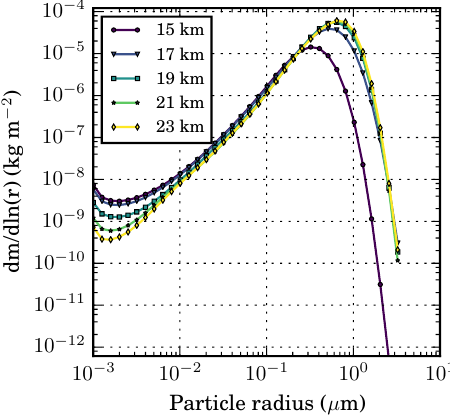
Figure 12. Column-integrated global and annual mean stratospheric aerosol mass size distribution (d m/ dln r , in kgm − 2 ) for the z _KM experiments with varying injection